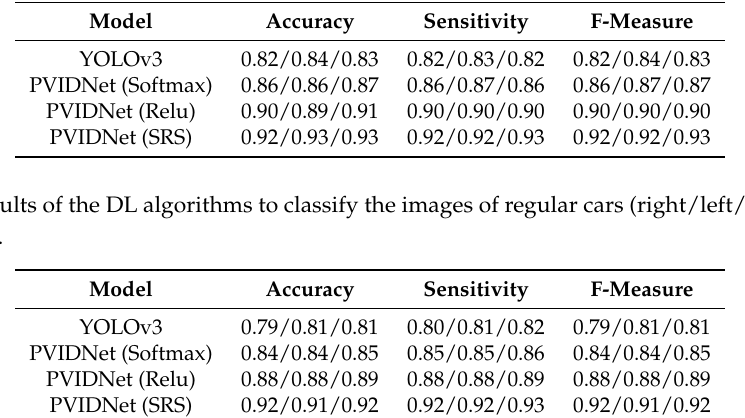
Table 14. Results of the DL algorithms to classify the images of police cars (right/left/front) in the testing phase.